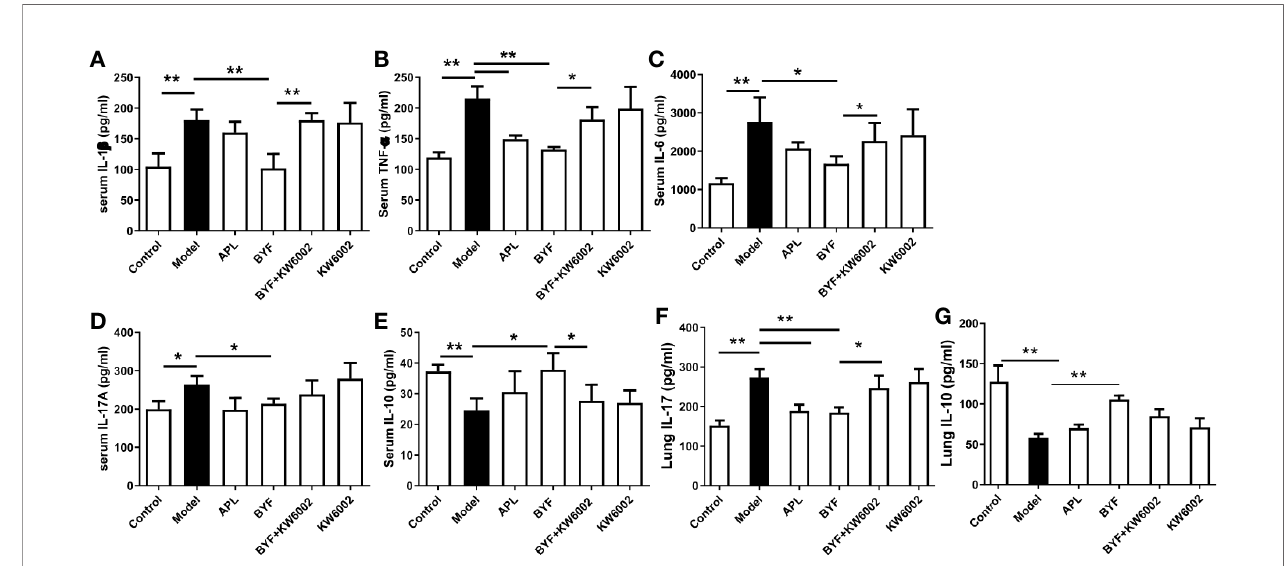
FIGURE 5 | Effect of cotreatment of Bufei Yishen formula (BYF) and A2aR antagonist on cytokine pro fi les in chronic obstructive pulmonary disease (COPD) rats. COPD rats were orally administrated with BYF, KW6002 and aminophylline. Cytokine levels of f IL-1 b , TNF- a , IL-6, IL-17A, and IL-10 in serum or lung tissues were detected by ELISA. The results were independently replicated. The values are presented as the means ± SEM (n= 6 mice per group). *P < 0.05, **P < 0.01.